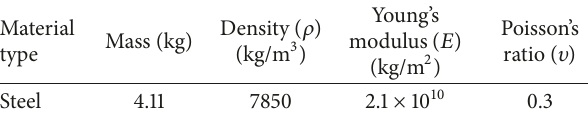
Table 3: Material properties of